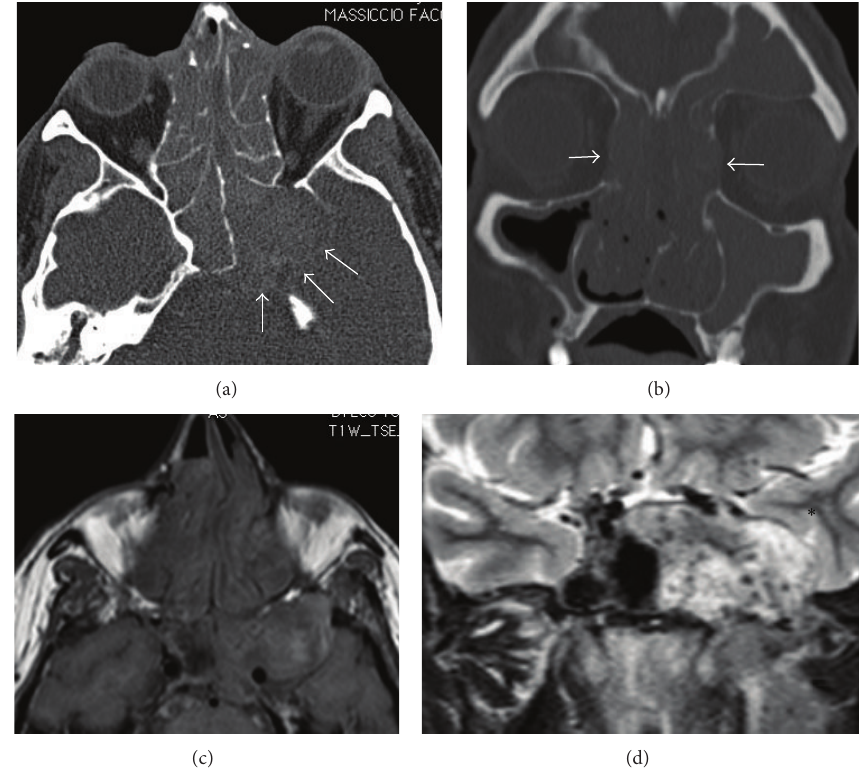
Figure 2: Maxillofacial and brain CT (a, b) and MRI (c, d). (a) Axial CT with contrast medium and (c) MRI-T1 weighted sequence showing abnormal extension of the left sphenoid sinus with thinning of the posterior and lateral bony walls (arrows) and compression of the temporal lobe (asterisk). (b) Coronal CT showing opacification of almost all paranasal sinuses associated with a focal erosion of the papyracea lamina (arrows). (d) Coronal T2-weighted MRI image showing temporal lobe compression (asterisk), while the left abducens nerve and cavernous sinus are not clearly recognizable.